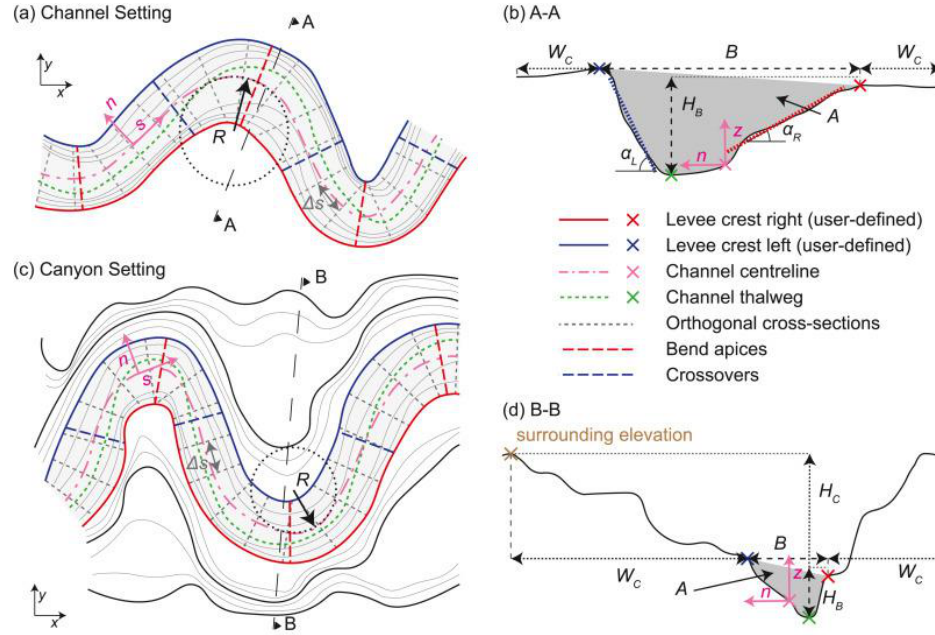
Figure 8. Determination of morphometric parameters of the river bed [91]. User-defined levee or bank crests (right in red, left in blue) for bankfull active channel in a channel ( a , b ) and canyon setting ( c , d ) and user-defined corridor width ( W C ) outside bankfull active channel.